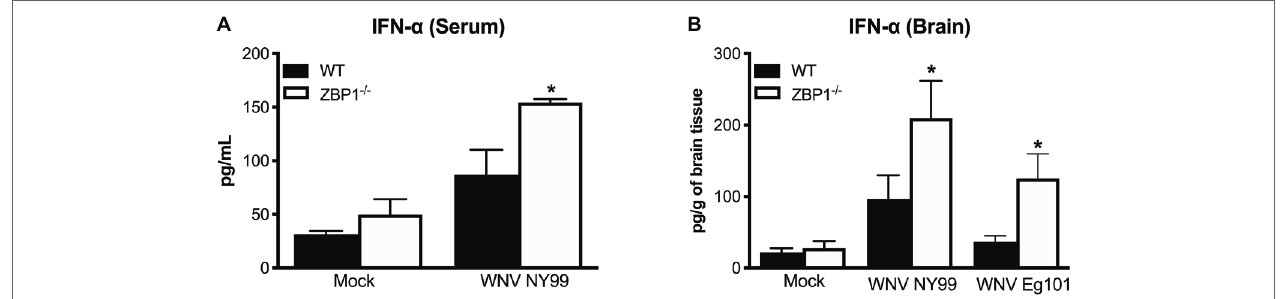
FIGURE 3 | IFN- α levels in the serum and brains of WT and ZBP1 −/− mice after infection with WNV NY99 or WNV Eg101. The protein levels of IFN- α were measured in the (A) serum and (B) brain homogenates using ELISA. Data represent the mean concentration (pg/ml) ± SEM or (pg/g of tissue) ± SEM ( n = 6–7 mice per group). * p < 0.05.